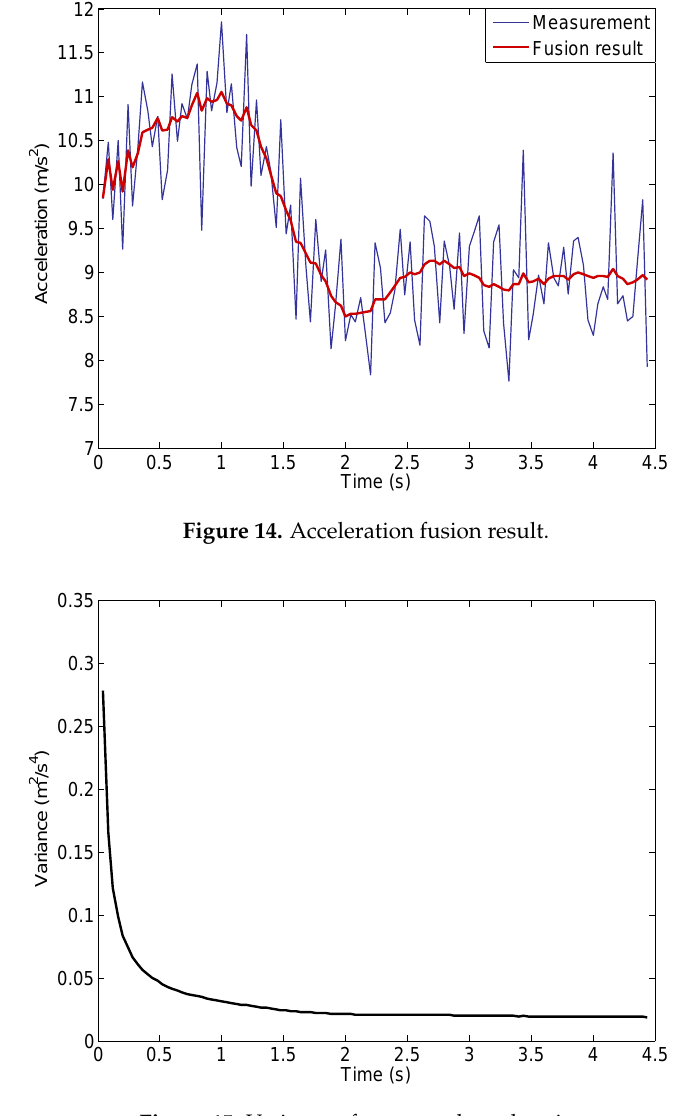
Figure 15. Variance of computed